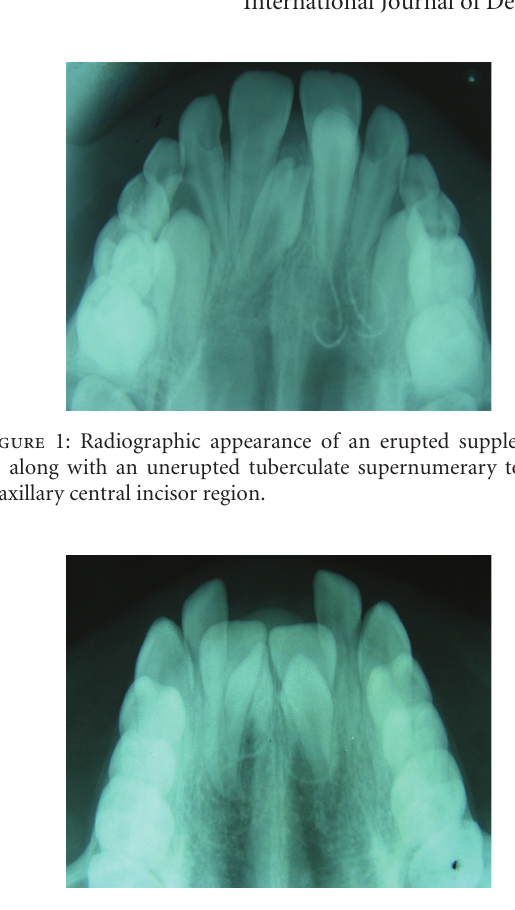
Figure 2: Two unerupted normally oriented conical supernumer- ary teeth causing failure of eruption of 11 and